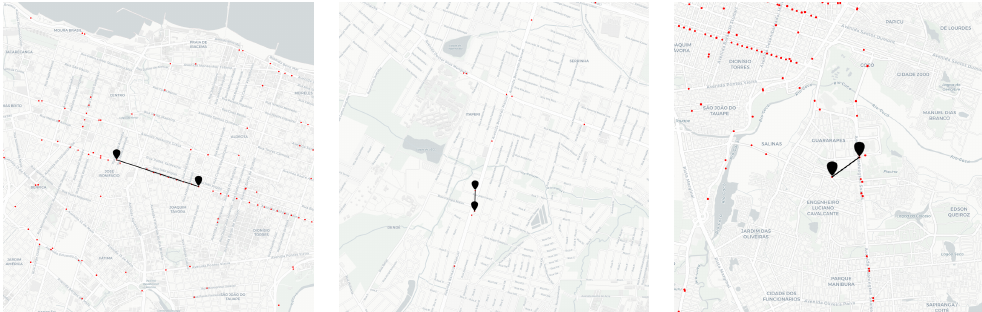
Figure 7. Example of nearest sensors according cosine distance between BERT MLM embedding